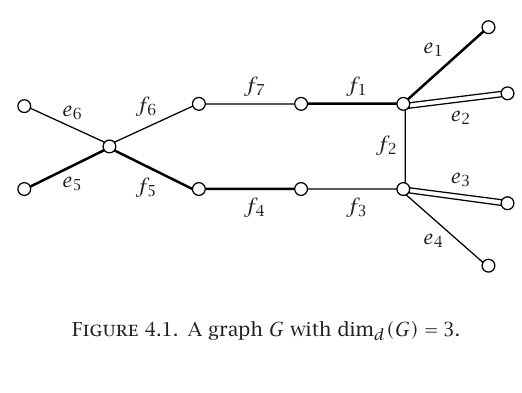
Figure 4.1 . A graph G with dim